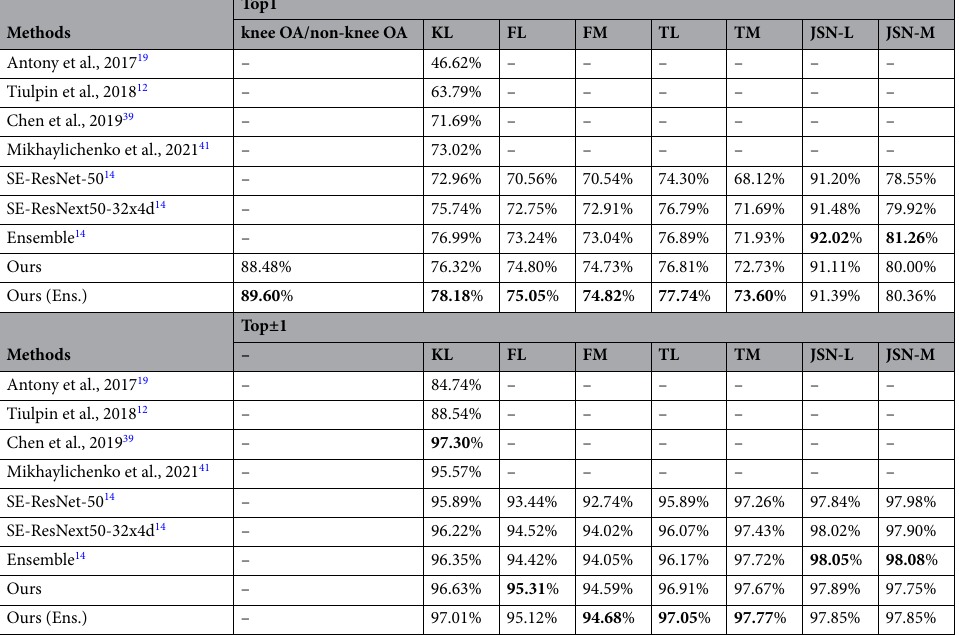
Experimental results and analyses of grading individual knee OA features. Detected knee images are randomly divided into training, validation, and test sets with a ratio of 5:1:3, whose KL distribution keeps consistent. Specific description of experimental data is presented in supplementary Table 1 and Table 2. Finally, 24265 detected knees from the OAI dataset are divided into 13472 training sets, 2732 validation sets and 8061 test sets. 18454 detected knees from the MOST dataset are divided into 10244 training sets, 2048 validation sets and 6162 test sets. These detected knee joint regions are further relocated to generate main knee joint areas. Comparison with state‑of‑the‑arts. Table 1 and Table 2 show experimental results of grading individual knee OA features, where ours (Ens.) represents an ensemble model (see supplementary Fig. 5) of SE-ResNext50- 32x4d and SE-ResNext50-32x4d-based Siamese network for eight tasks. As for the single model on the OAI dataset, Table 1 shows that our proposed method (ours) is superior to methods proposed by Antony et al. 19 , Tiulpin et al. 12 , Chen et al. 39 , Mikhaylichenko et al. 41 , SE-ResNet-50 14 model and SE-ResNext50-32x4d 14 model in most cases for top1 accuracy; As for the ensemble model on the OAI dataset, ours (Ens.) is better than ensem- ble model 14 except for JSN-L and JSN-M in top1 and top±1 accuracy. Table 1 clarifies that the optimal top1 accuracy of assessing knee OA/non-knee OA, KL grades, FL grades, FM grades, TL grades, TM grades, JSN-L grades and JSN-M grades are 89.60%, 78.18%, 75.05%, 74.82%, 77.74%, 73.60%, 92.02% and 81.26%, respec- tively; 97.30%, 95.31%, 94.68%, 97.05%, 97.77%, 98.05% and 98.08% are best top±1 prediction accuracy of KL grades, FL grades, FM grades, TL grades, TM grades, JSN-L grades and JSN-M grades on the OAI dataset, most of which are obtained under ours (Ens.). From Table 2, we can observe that ours and ours (Ens.) both outper- form previous state-of-the-art models in top1 and top±1 accuracy in most cases. The highest top1 accuracy of predicting knee OA/non-knee OA, KL grades, FL grades, FM grades, TL grades, TM grades, JSN-L grades and JSN-M grades are 92.84%, 77.86%, 82.05%, 80.54%, 80.12%, 76.71%, 93.69% and 84.83%, respectively, which are mainly generated by our proposed methods except for JSN-L grades and JSN-M grades. Our proposed single model reaches the best top±1 accuracy of 98.59%, 95.55%, 94.06%, 96.87%, 98.15%, 98.33% in grading KL, FL, FM, TL, TM, JSN-L, respectively. And the best top±1 accuracy of 98.31% in grading JSN-M is achieved under ours (Ens.) method. The single model we proposed even surpasses the ensemble model 14 in most cases on two databases. We also evaluate our proposed algorithms from Kappa and MSE metrics as shown in supplementary Table 3 and Table 4, where our proposed methods have higher Kappa and lower MSE than existing state-of-the- arts in most cases. In order to further verify the effectiveness of our algorithm, we extend experiments, using the OAI dataset as the training set and the MOST dataset as the test set. It avoids the influence of knee images with different months of the same person appearing in the training set and the test set. Supplementary Table 5 and Table 6 demonstrate that our methods outperform advanced works, having higher top1 accuracy, top±1 accu- racy, Kappa and lower MSE in most cases. Thus, we can conclude that our proposed methods have the state-of- the-art performance, which extract more useful, richer features and semantic information, improving prediction performance in grading individual knee OA features.